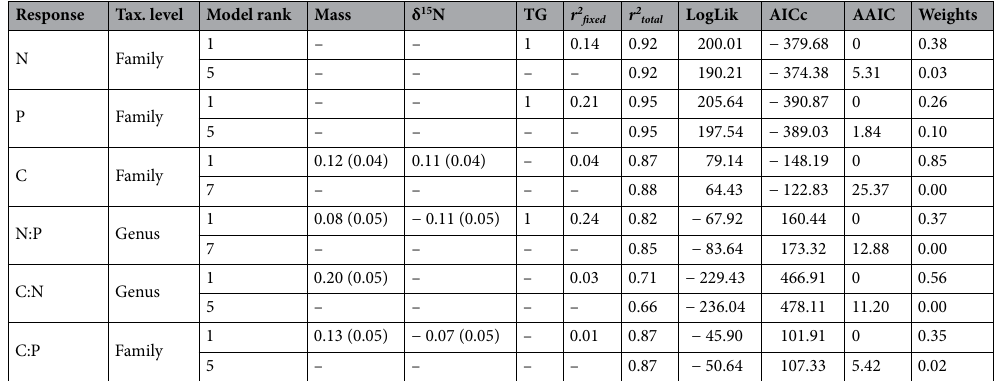
Table 2. Statistics for mixed-effects model output and rank for body nutrient composition that include random effects of taxonomic level and ecological covariates: Mass = wet body mass (continuous; log10 transformed), δ 15 N (continuous), and TG = trophic group classifications (categorical). r 2 fixed and r 2 total indicates the variation in the data explained by the fixed effects and the full model, respectively 50 . For Mass and δ 15 N, values are parameter estimates (with standard error). For TG, a “1” indicates inclusion in the model (estimates not